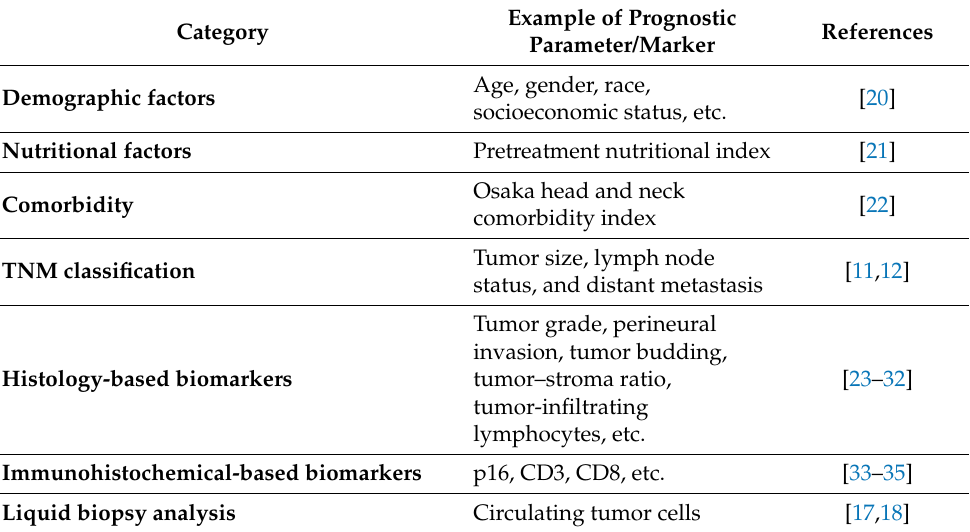
Table 1. Summary of prognostic classifiers/markers in head and neck squamous cell